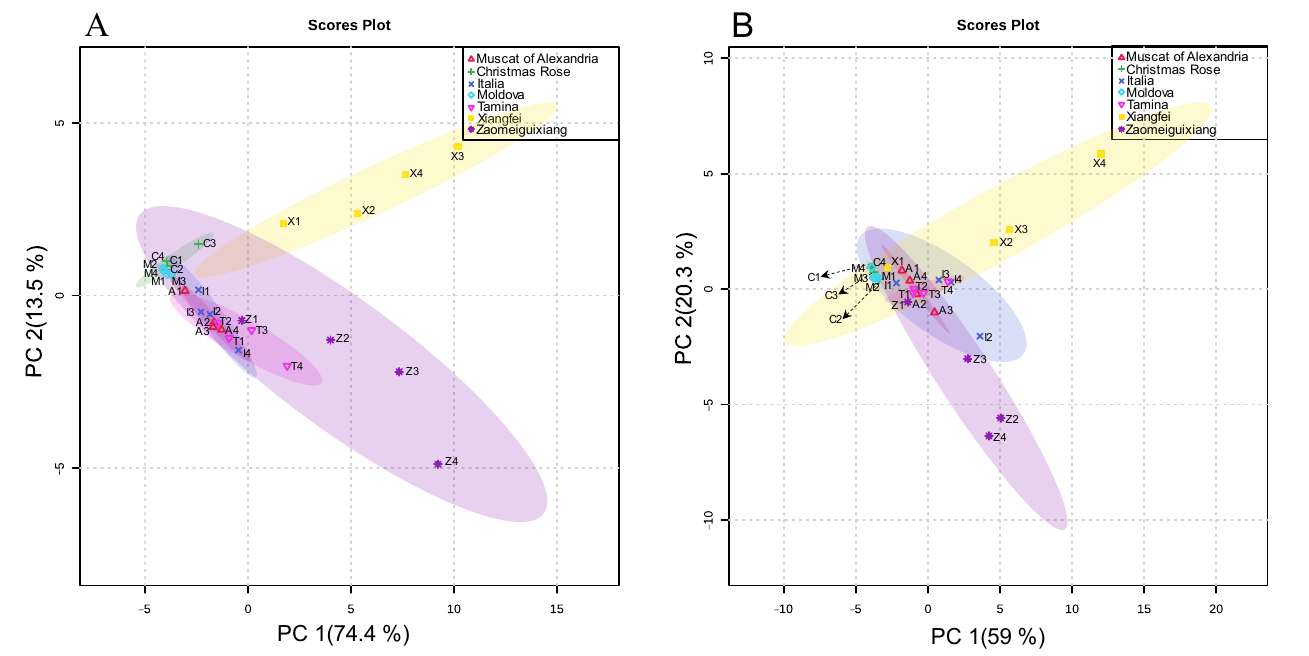
Figure 2. Principle component analysis of monoterpenoids composition in different table grape varieties during berry development in 2013 ( A ) and 2014 ( B ). A represented ‘Muscat of Alexandria’; C represented ‘Christmas Rose’; I represented ‘Italia’; M represented ‘Moldova’; T represented ‘Tamina’; X represented ‘Xiangfei’; Z represented ‘Zmeiguixiang’. 1 represented E-L35; 2 represented E-L36; 3 represented E-L37; 4 represented